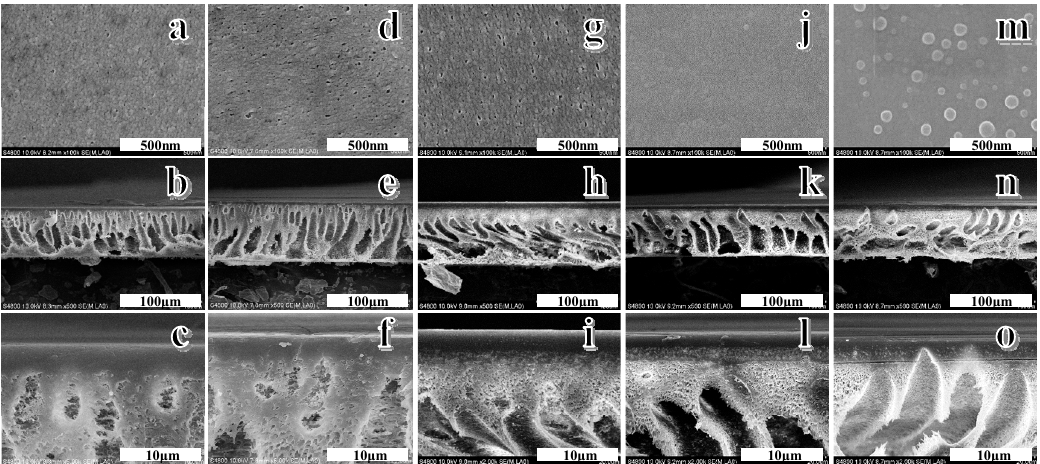
Figure 6. SEM images of the PSf/PES membrane ( a – c ), the PSf/PES-AM-VT 0.5 membrane ( d – f ), the PSf/PES-AM-VT 1.0 membrane ( g – i ), the PSf/PES-AM-VT 2.0 membrane ( j – l ), and the PSf/PES-AM-VT 3.0 membrane ( m – o ) at different